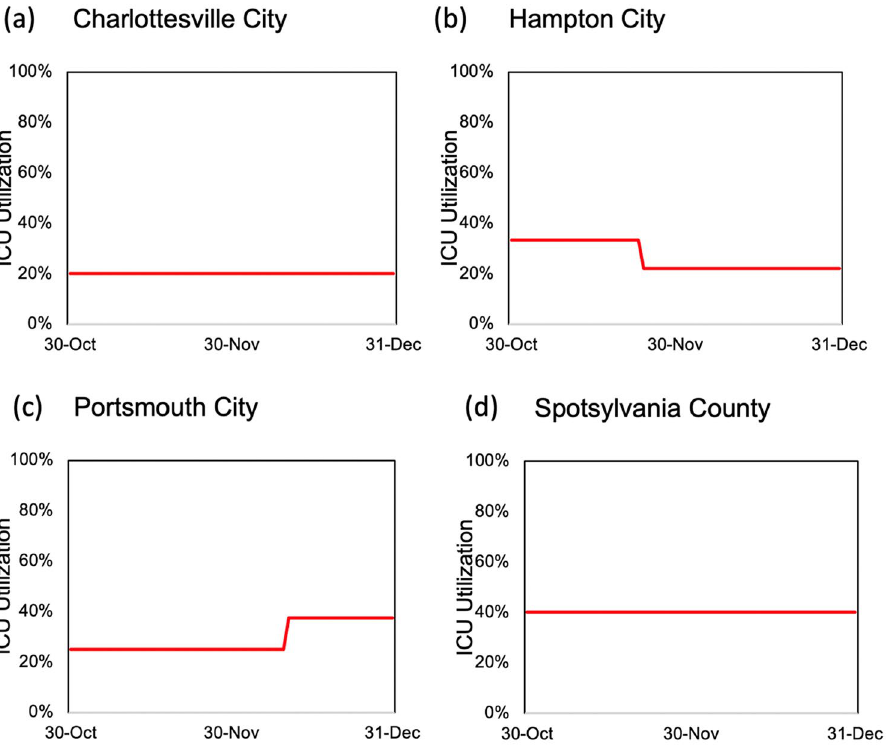
Figure 7. COVID-19 ICU bed utilization projections based on the mean estimated RE t values for four localities in Virginia: ( a ) Charlottesville City, ( b ) Hampton City, ( c ) Portsmouth City, and ( d ) Spotsylvania County.